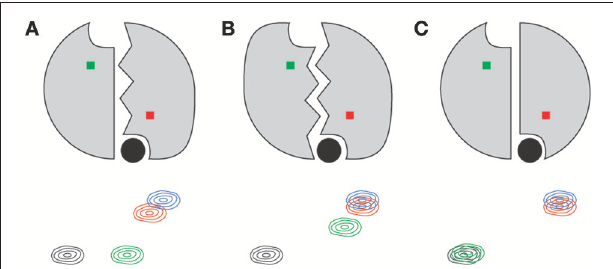
FIGURE 8 | Simple structure-based expectations of quartet peak positions for a symmetric dimer such as thymidylate synthase. Ligand is shown as a filled black circle for each lig 1 state shown. The residue amide giving rise to the 2D peaks are shown as red and green squares, corresponding to the bound and empty subunits, respectively. Conformational change in a protomer is indicated by jagged lines at the interface. Panels indicate conformational change in the binding protomer only (A) , both protomers (B) , and in neither (C)